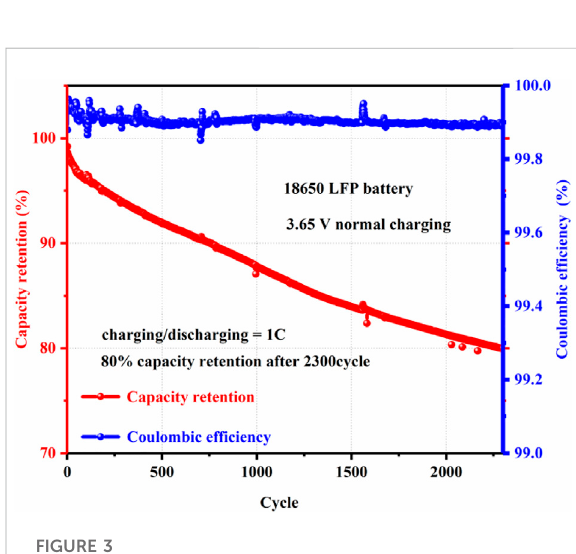
FIGURE 3 Capacity retention and Coulombic ef fi ciency under normal charging